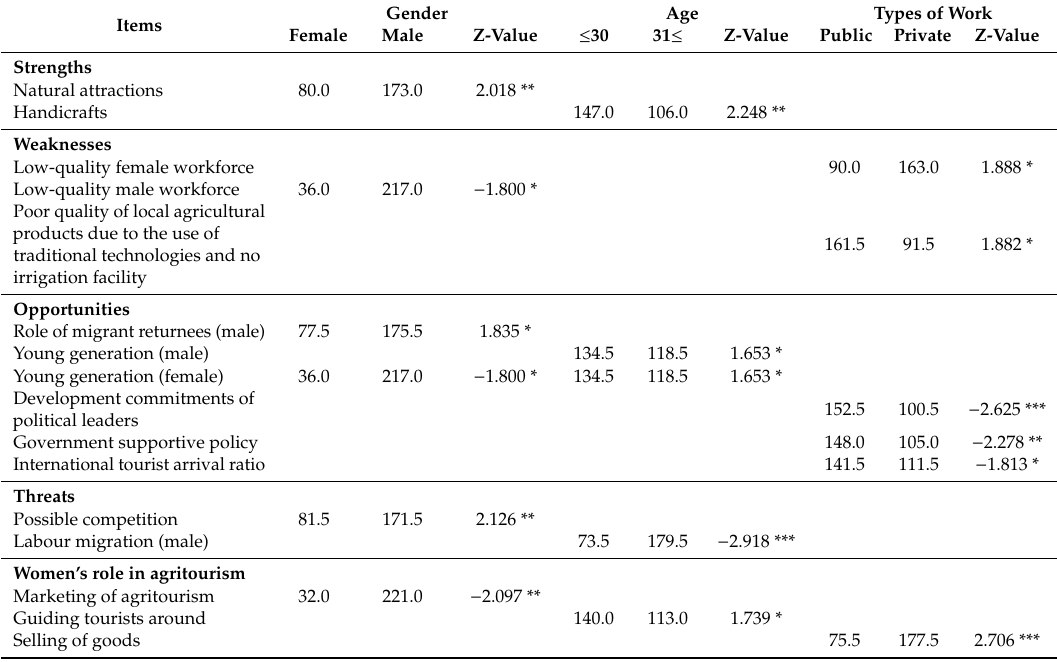
Table 6. Comparing the di ff erent opinions of the respondents based on gender, age, and types of work (the Wilcoxson Mann–Whitney rank-sum